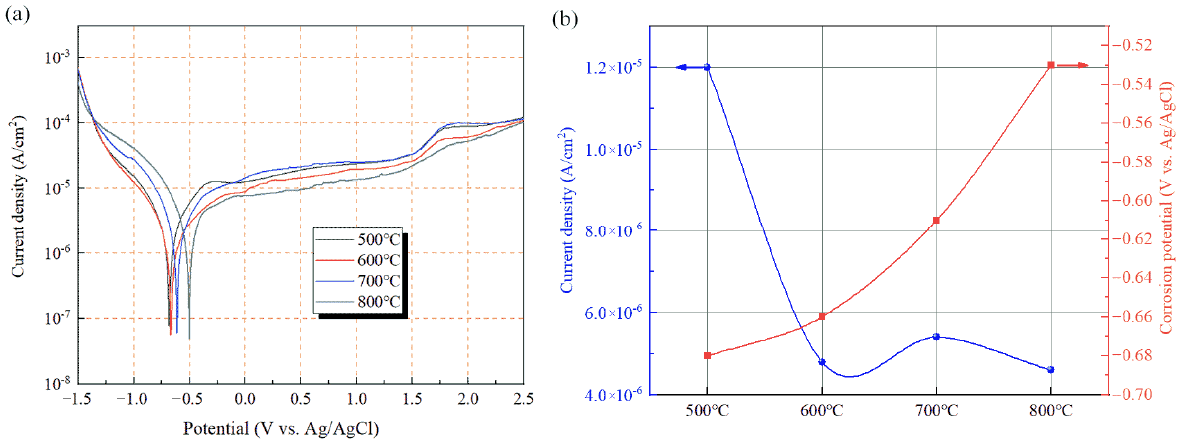
Figure 9. ( a ) Polarization curves of Ti-20Zr-15Mo alloys at different annealing temperatures; ( b ) trend of corrosion potential and corrosion current density.